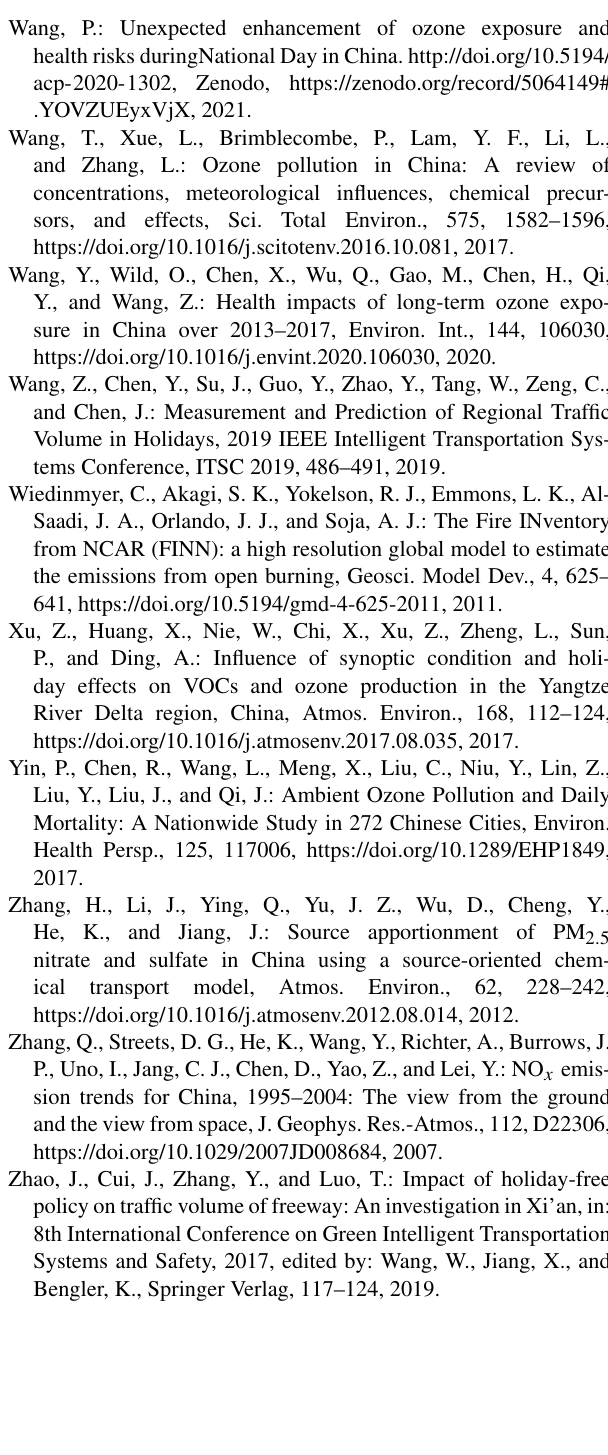
National Bureau of Statistics of China: Tabulation on the 2010 Pop- ulation Census of the People’s Republic of China, available